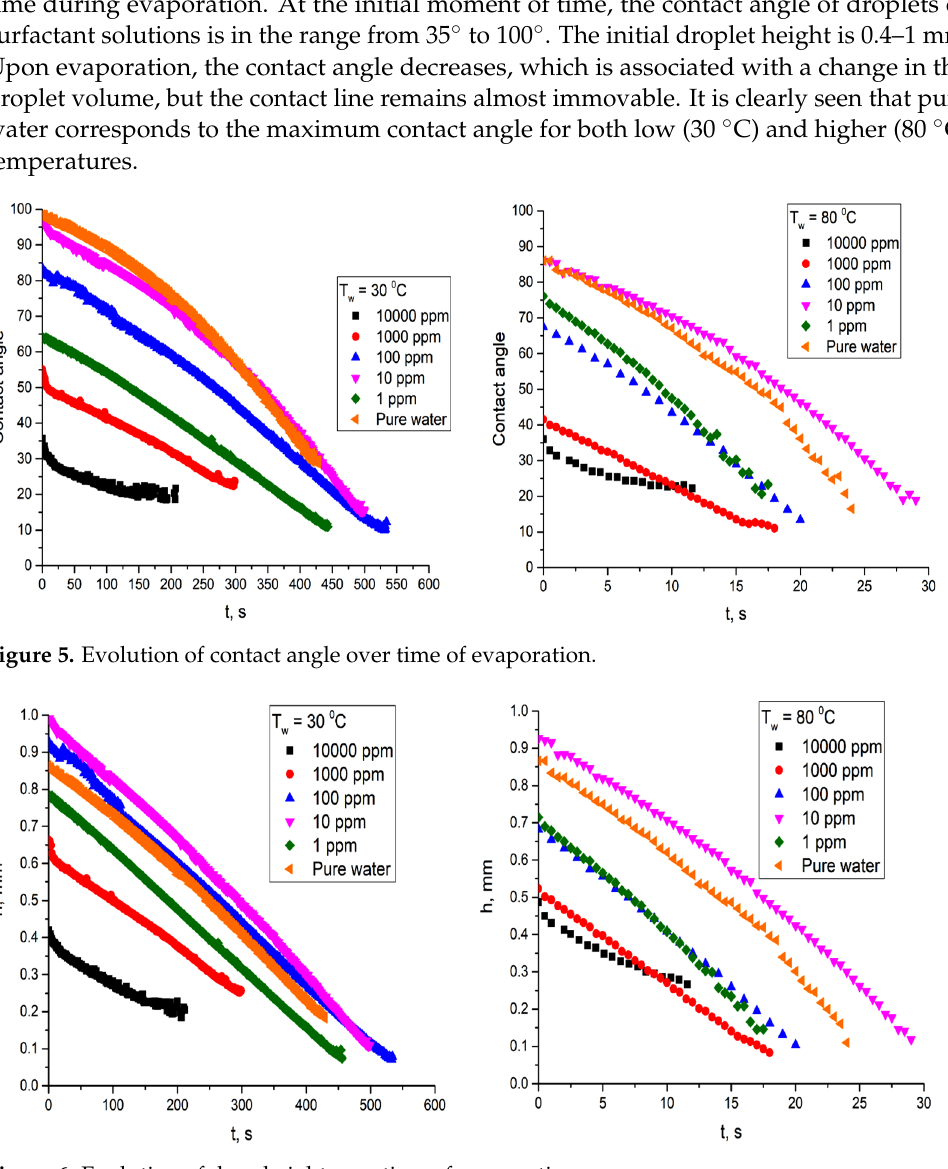
Figure 6. Evolution of drop height over time of evaporation.